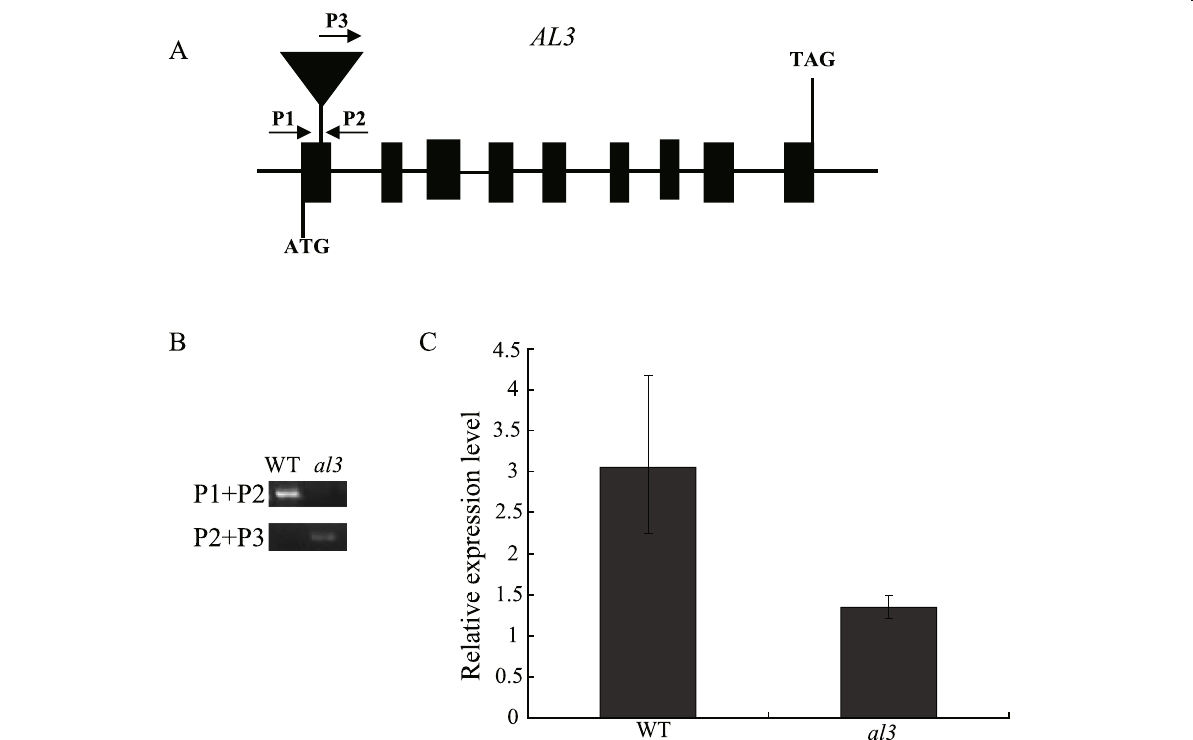
Fig. 2 Molecular cloning of AL3 . a Schematic representation of the AL3 gene. Black boxes represent exons, and the lines represent introns. T-DNA is inserted into the first exon of LOC_Os05g51450 . b PCR verification of the T-DNA insertion site. c Expression level of AL3 in the wild-type and